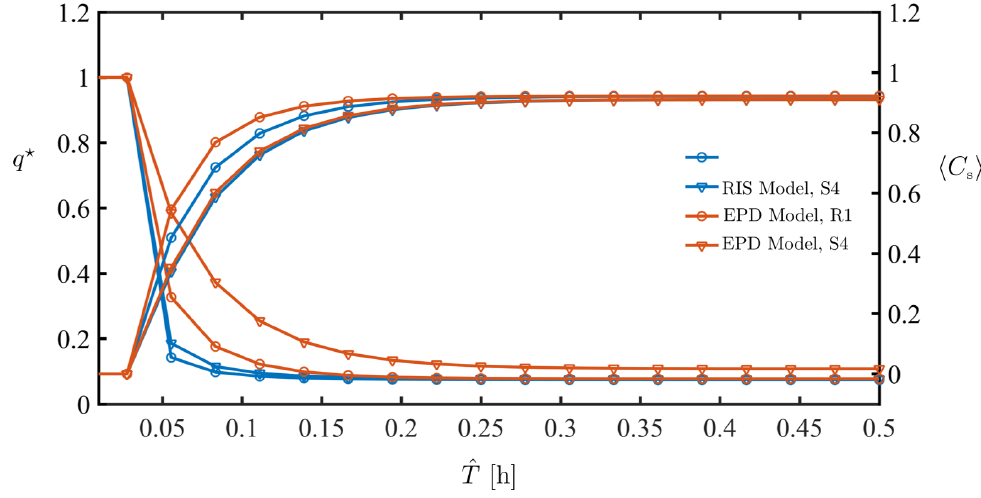
Figure 6. Comparison of the flux decline (left axis) of R1 and S4, and foulant accumulation (right axis) of R1 and S4 using RIS and EPD boundary